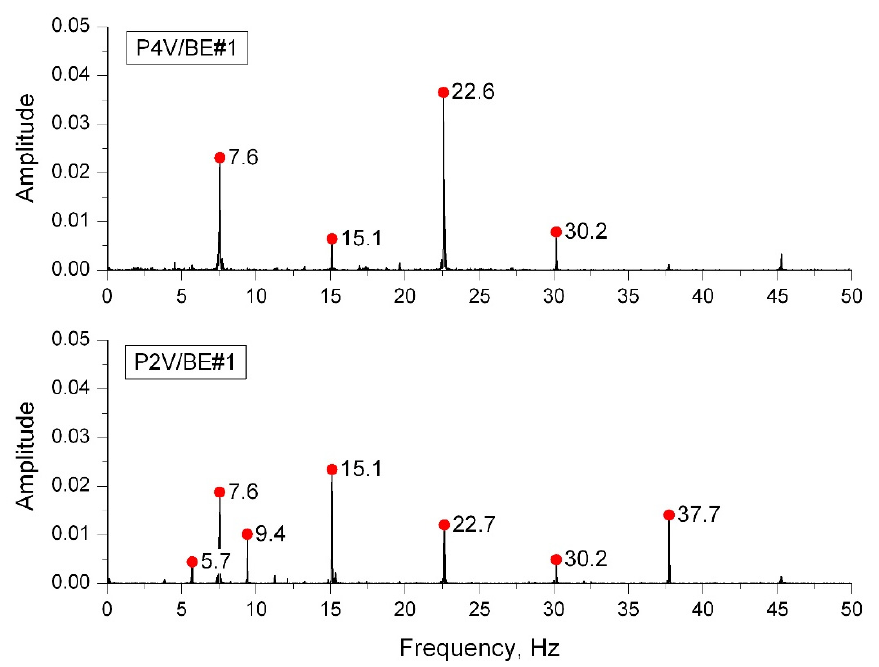
Figure 14. Narrow-band spectra of the RMS vibration velocity at points P2 and P4 in the drive unit of bucket elevator BE#1 (the numbers in the graphs indicate the characteristic frequencies in